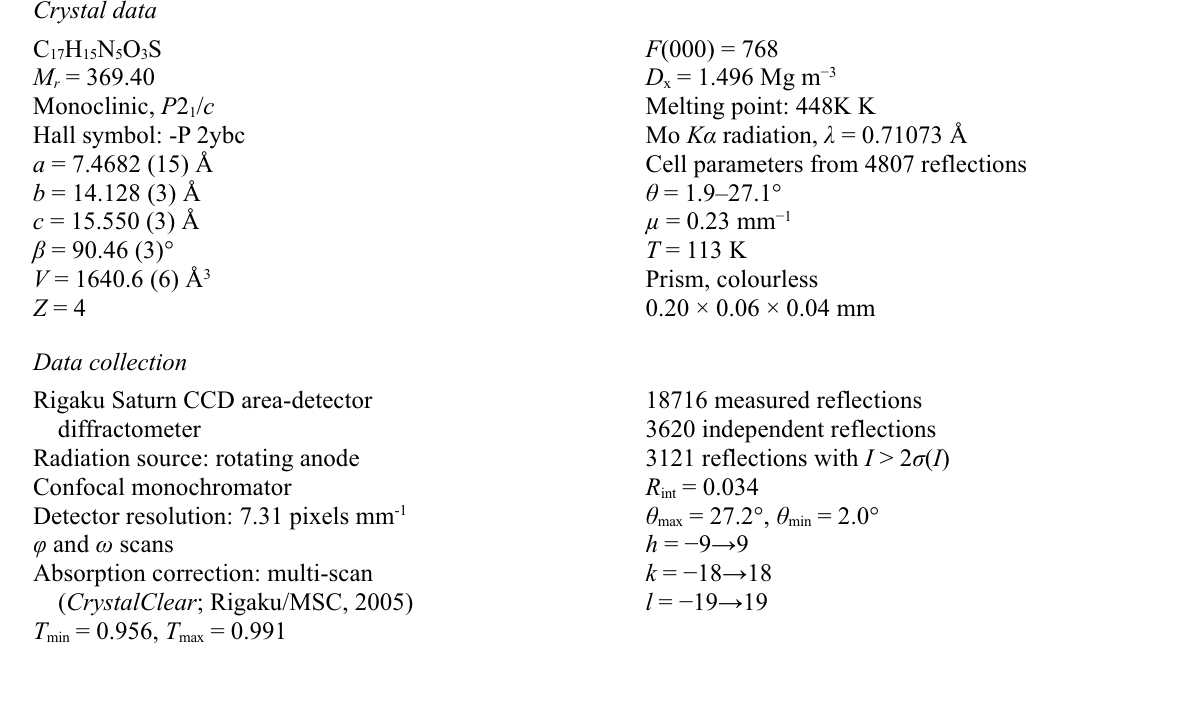
The molecular structure of the title molecule, with the atom-numbering scheme. Hydrogen bond is shown as dashed line.